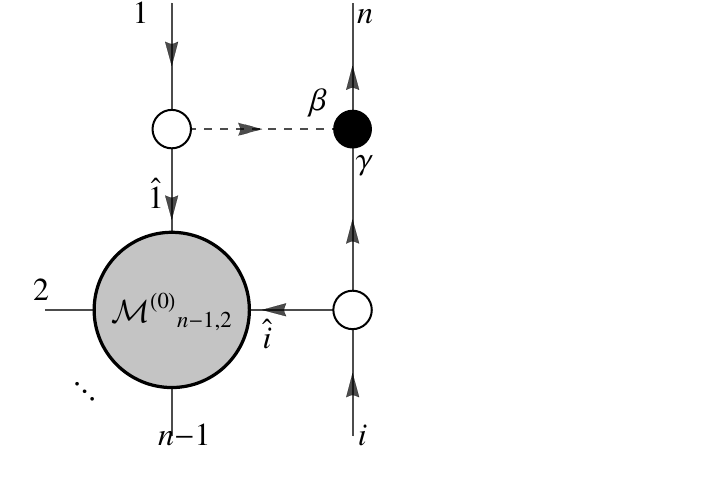
Figure 9 . On-shell diagram contributing to tree-level n -point MHV tree amplitude in N = 8